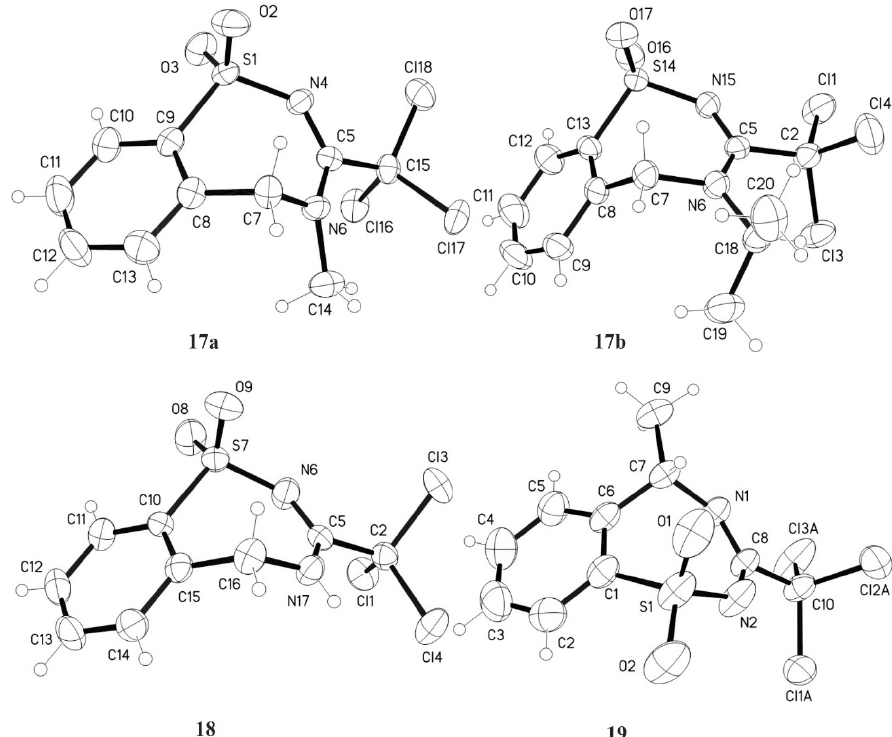
Figure 6. Molecular structure of 4,5 ‐ dihydro ‐ 1,2,4 ‐ benzothiadiazepine ‐ 1,1 ‐ dioxides 17a , b , 18 , 19 including thermal displacement ellipses with 50% probability.